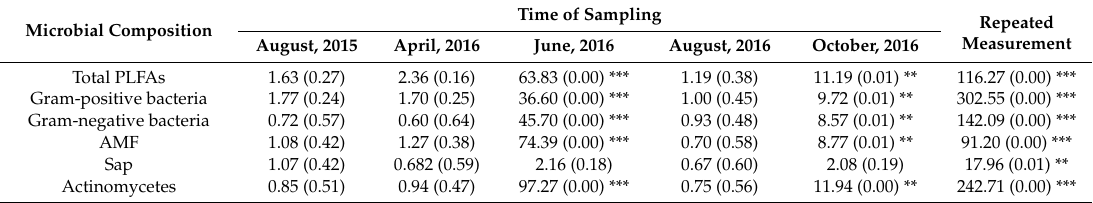
Table 2. F-values and p -values (in parentheses) for significance tests of the e ff ects in di ff erent thinning treatments on soil microbial variables. Microbial Composition